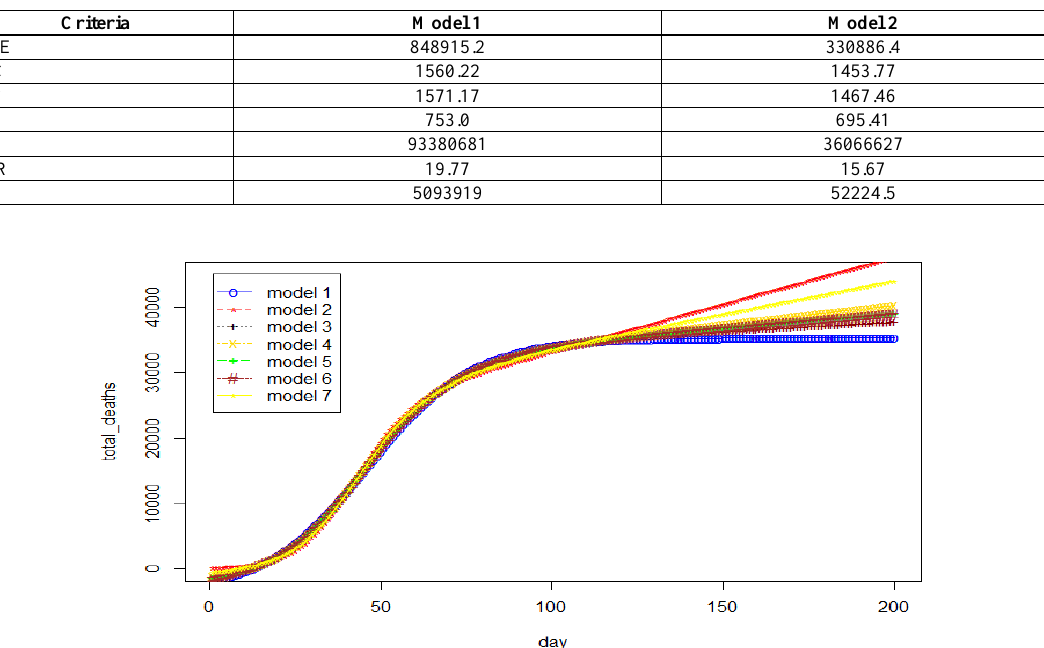
Figure 6: Daily death toll vs. day in Italy Table 4. Model selection criteria based on available data in Italy